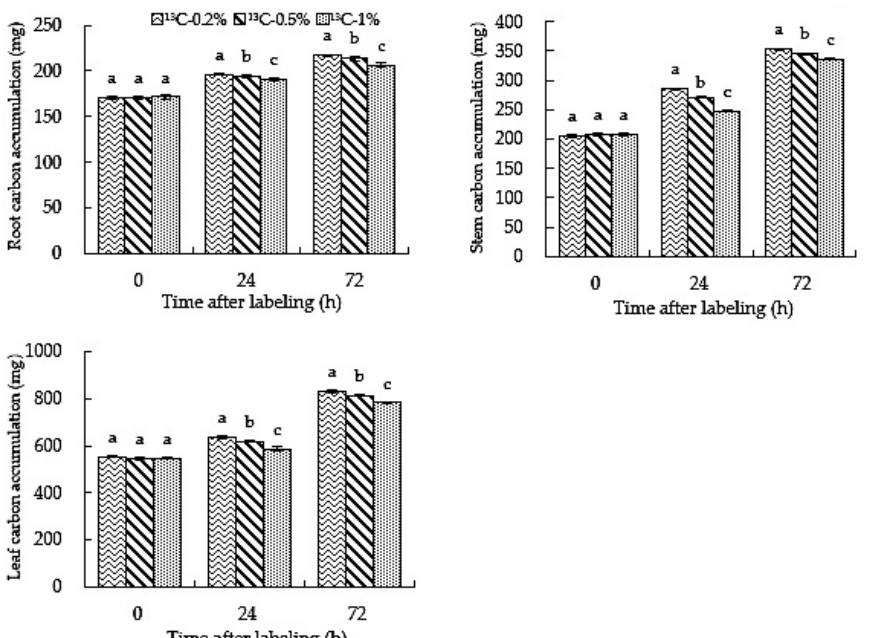
Figure 7. High root-zone 13 CO 2 affects carbon accumulation in roots, stems and leaves of oriental melon. Standard errors (SEs) of the means are represented by error bars. Different letters in the same row indicate significance at the 0.05 level among treatments.